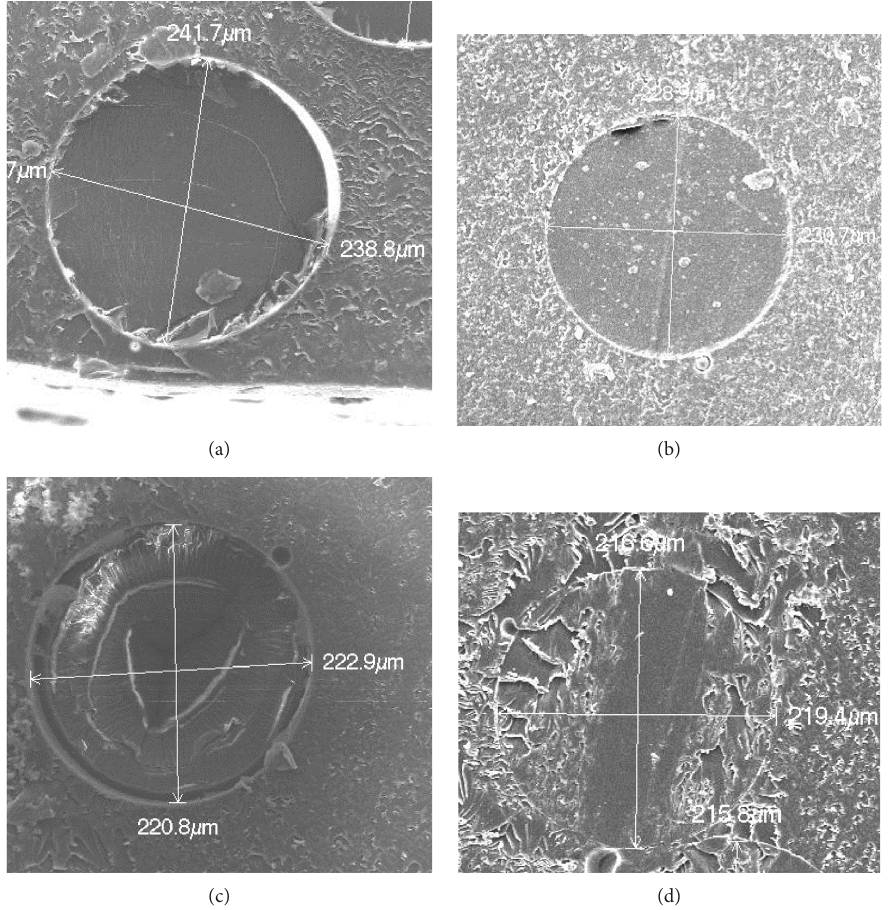
Figure 13: Chemical clad removal using DMF with different immersion times. (a) 30 minutes. (b) 1 hour. (c) 2 hours. (d) 3